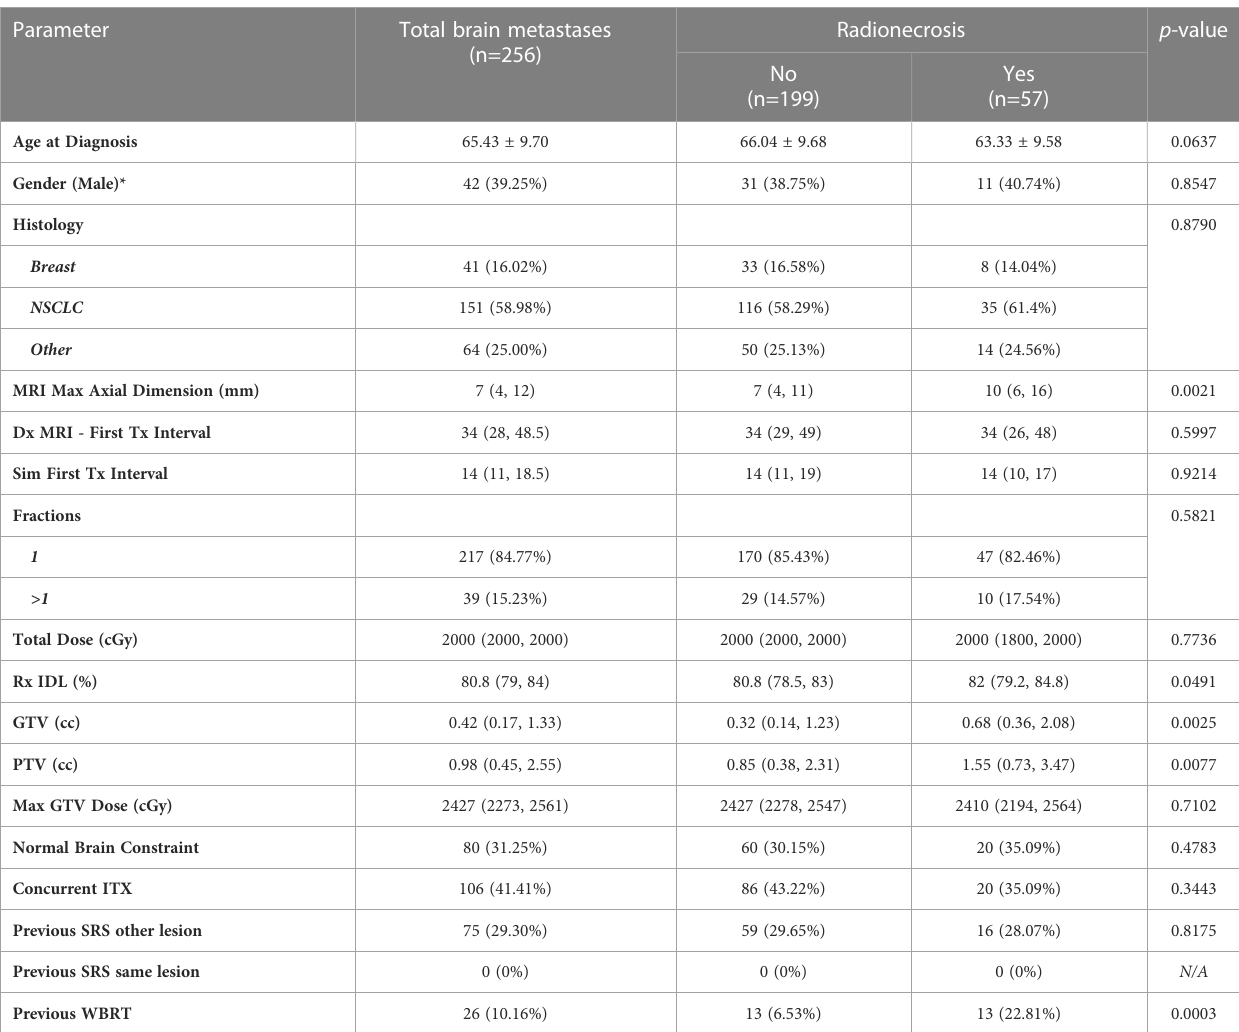
TABLE 1 Univariate analyses comparing radionecrosis (Yes vs.